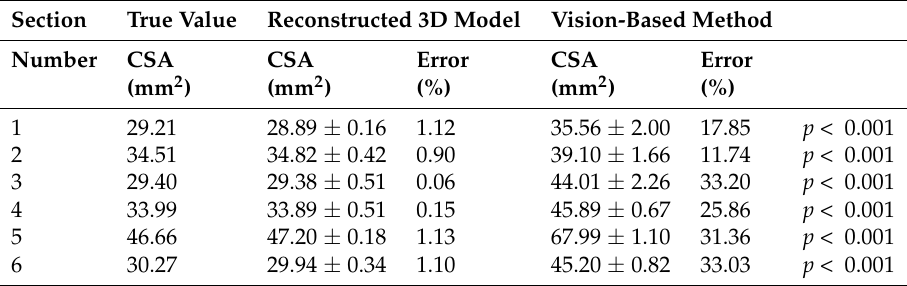
Table 2. The results of CSA measurements of the biological sample (wooden twig) at 6 points of the sample and corresponding relative errors using our 3D scanning system and vision-based method. Number of repeated measurements per point n = 6. Data are presented as means with standard